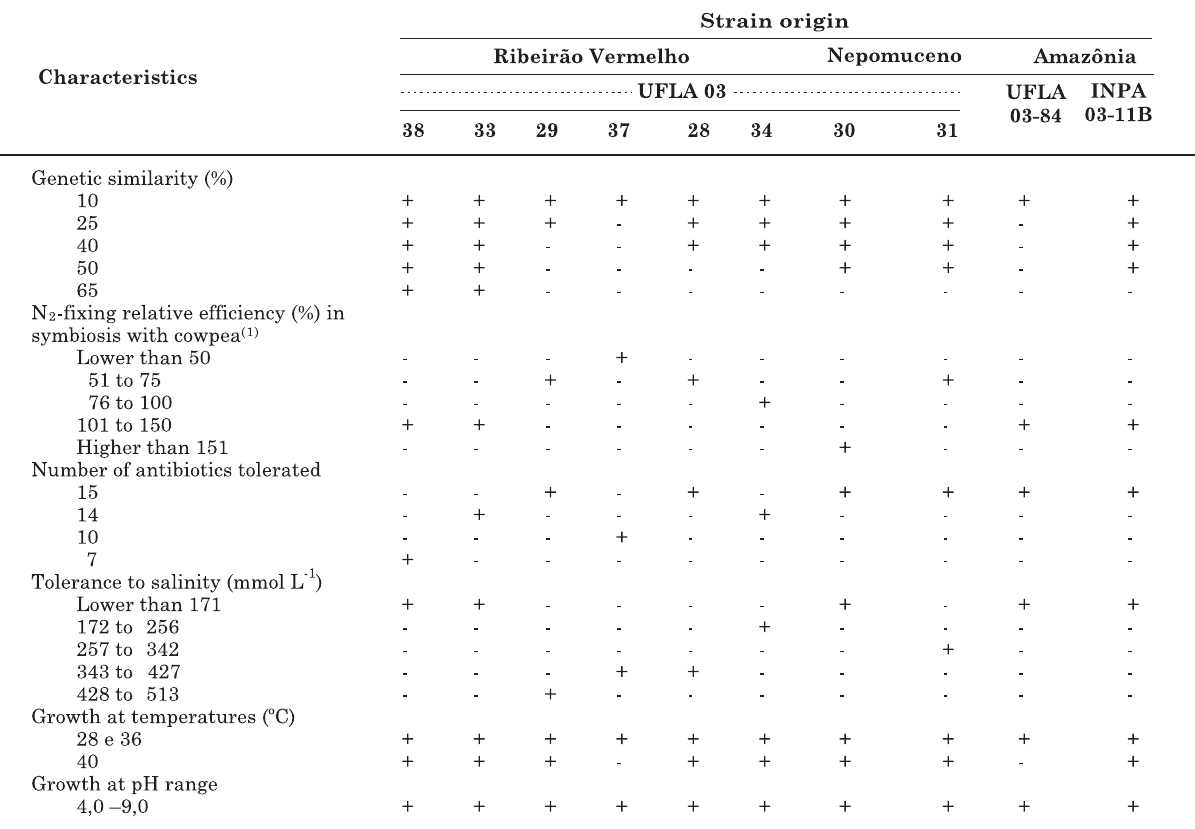
Table 4. Correlation between rhizobia strain origin and their genotypic and phenotypic characteristics and symbiotic efficiencies